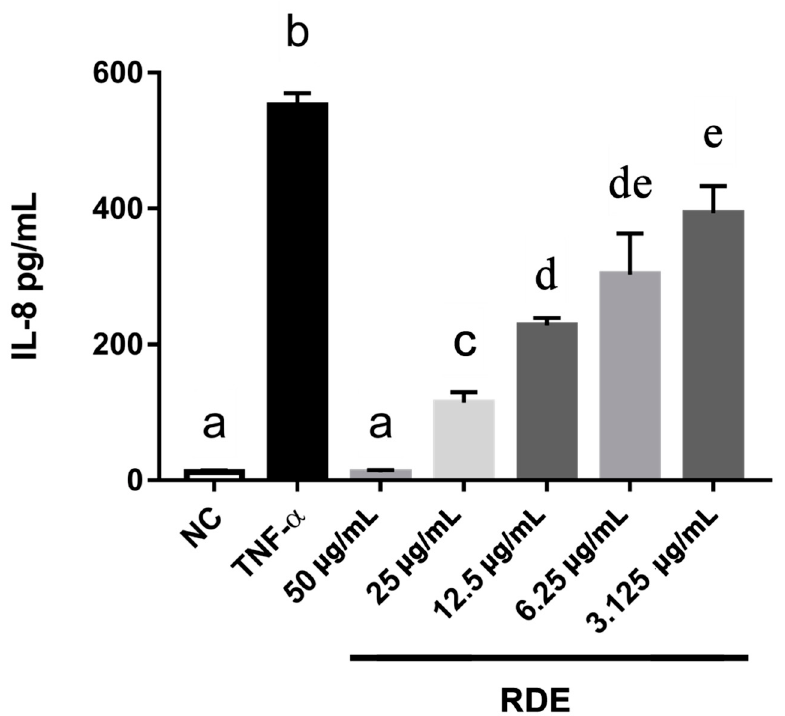
Figure 2. Production of IL-8 in Caco-2 cells in response to no inflammation (NC), TNF- α induced inflammation (TNF- α ), or a series of RDE concentrations with the following TNF- α induced inflammation. Caco-2 cells were pretreated with a series of concentrations (3.125, 6.25, 12.5, 25, and 50 μ g/mL) of RDE for 1 h, followed by incubation with 2 ng/mL TNF- α for 4 h. Values are presented as means ± SEM, n = 4. Shared letters indicate no significant difference ( p > 0.05).